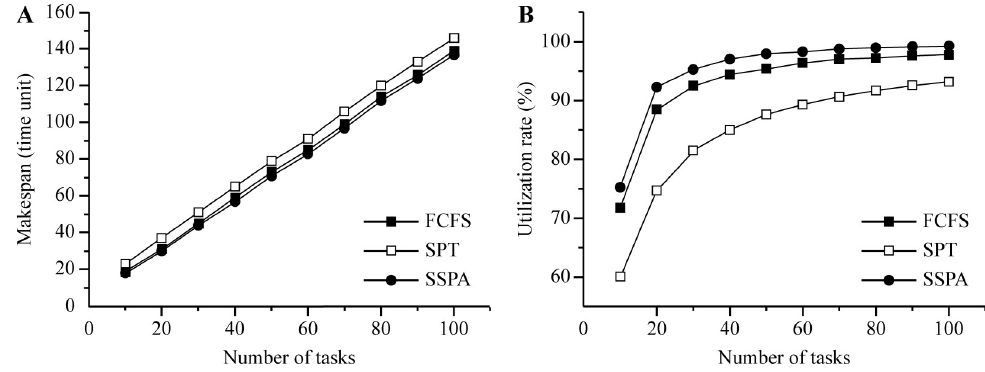
Fig 9. Results for variable number of tasks. (a) Makespan and (b) utilization rate.